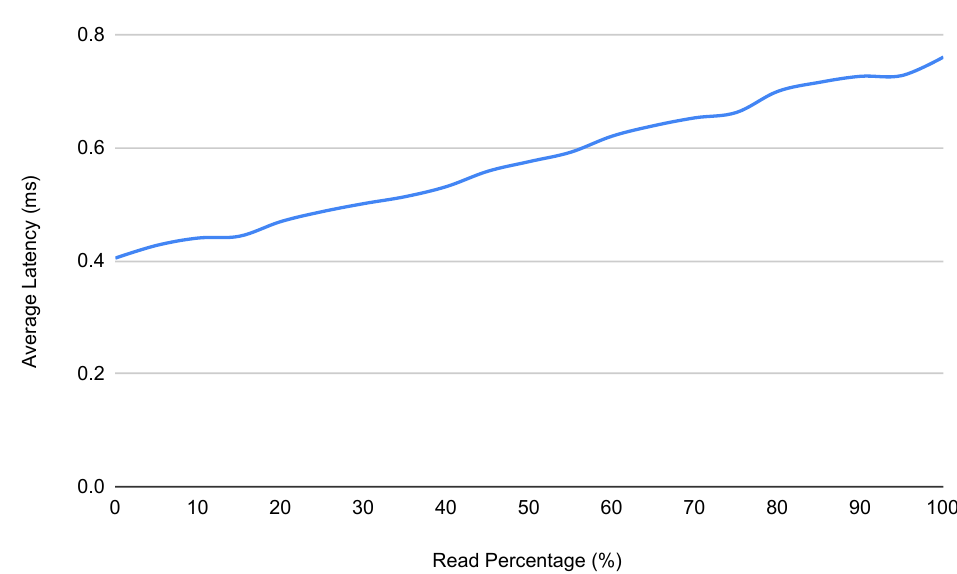
Figure 13. Average Verification Latency per Operation for Various Read Percentages.